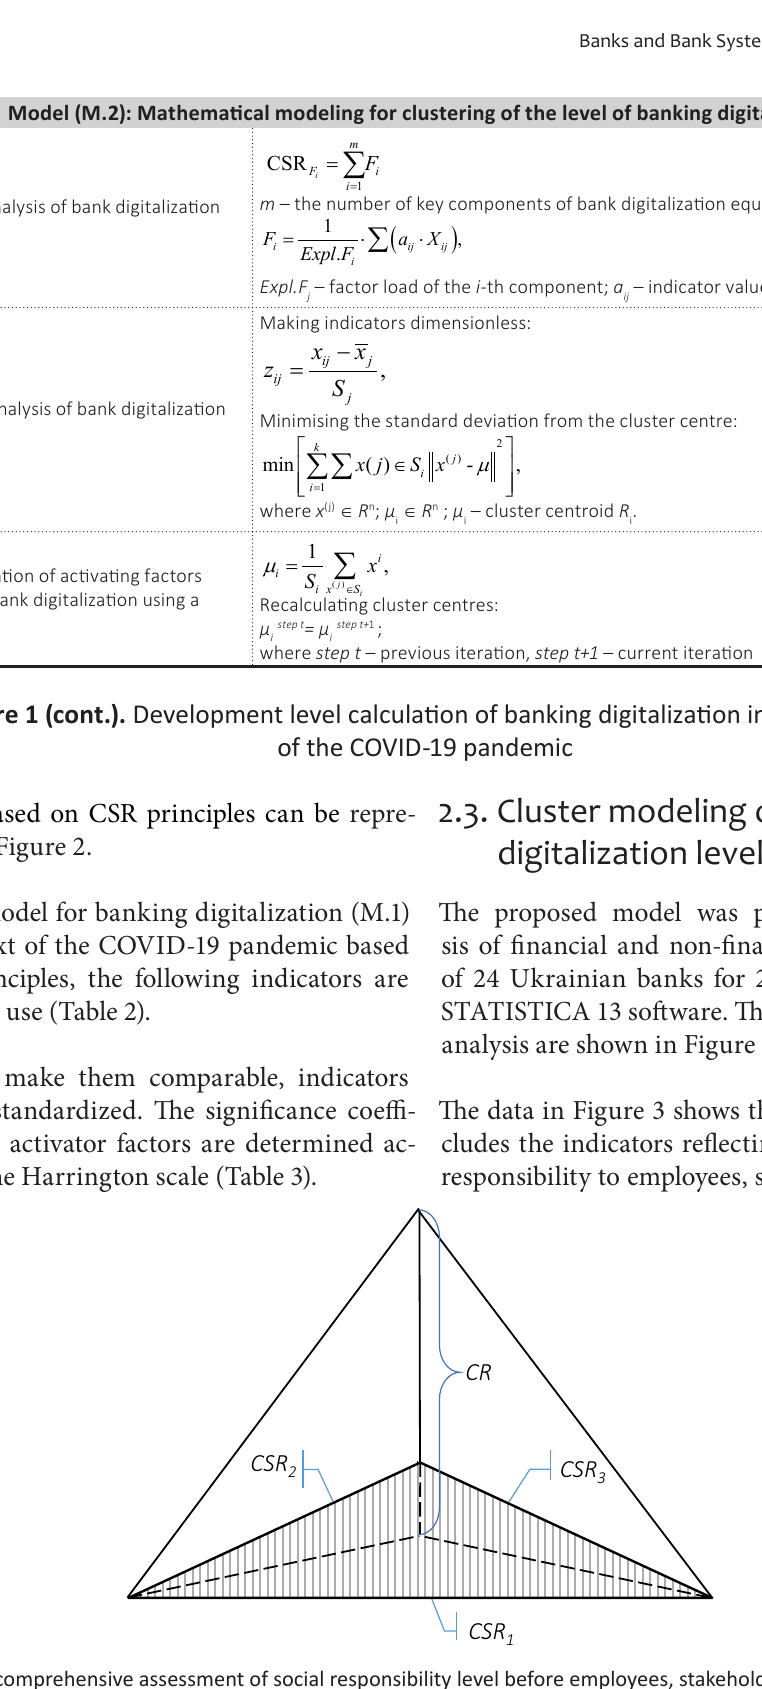
Figure 2. Model for banking digitalization in the context of the COVID-19